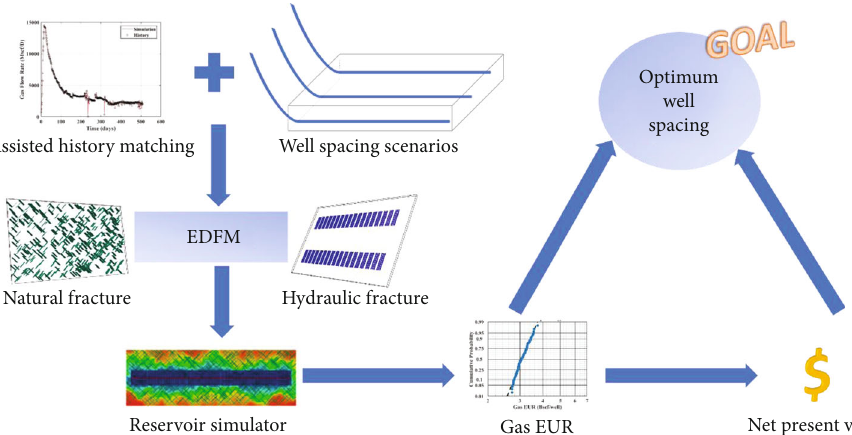
Figure 1: An integrated AHM and EDFM work fl ow for well spacing optimization in shale gas reservoirs with complex natural fractures.